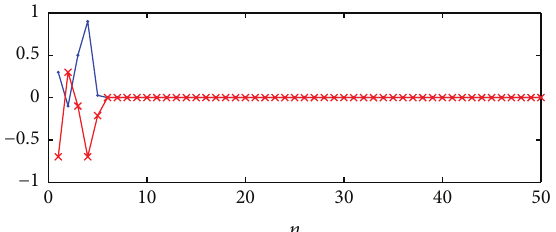
Figure 3: The response curves of system (39) without impulsive effects.